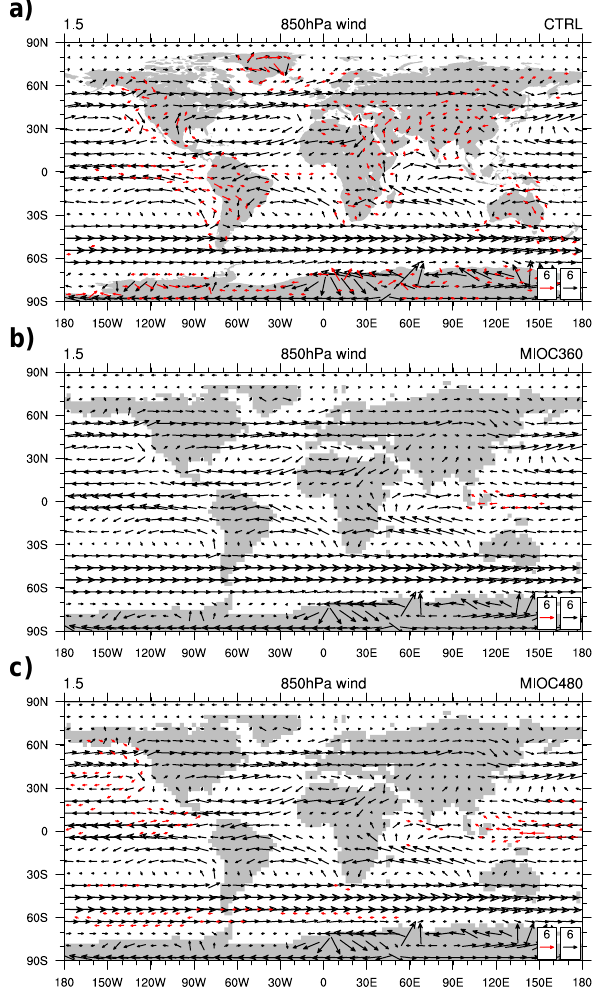
Fig. 7. Low level wind field in (a) CTRL (black arrows) and the difference to MIOC360 (red arrows), (b) MIOC360 and the difference to MIOC480, and (c) MIOC480 and the difference to MIOC720. The lower right reference arrows correspond to a veloc- ity of 6ms − 1